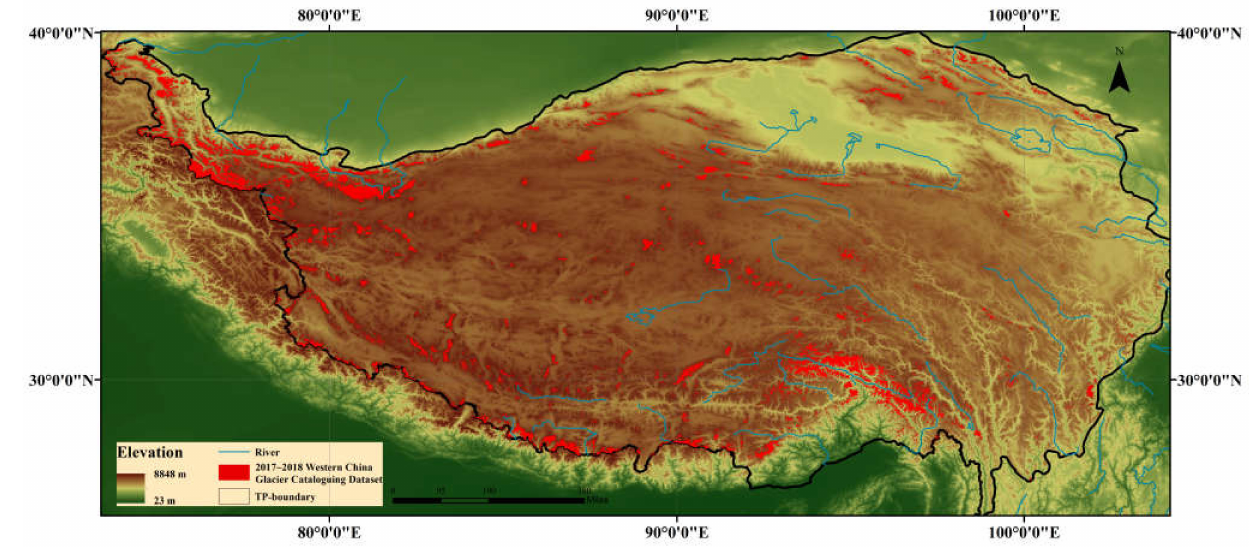
Figure 1. Study region.